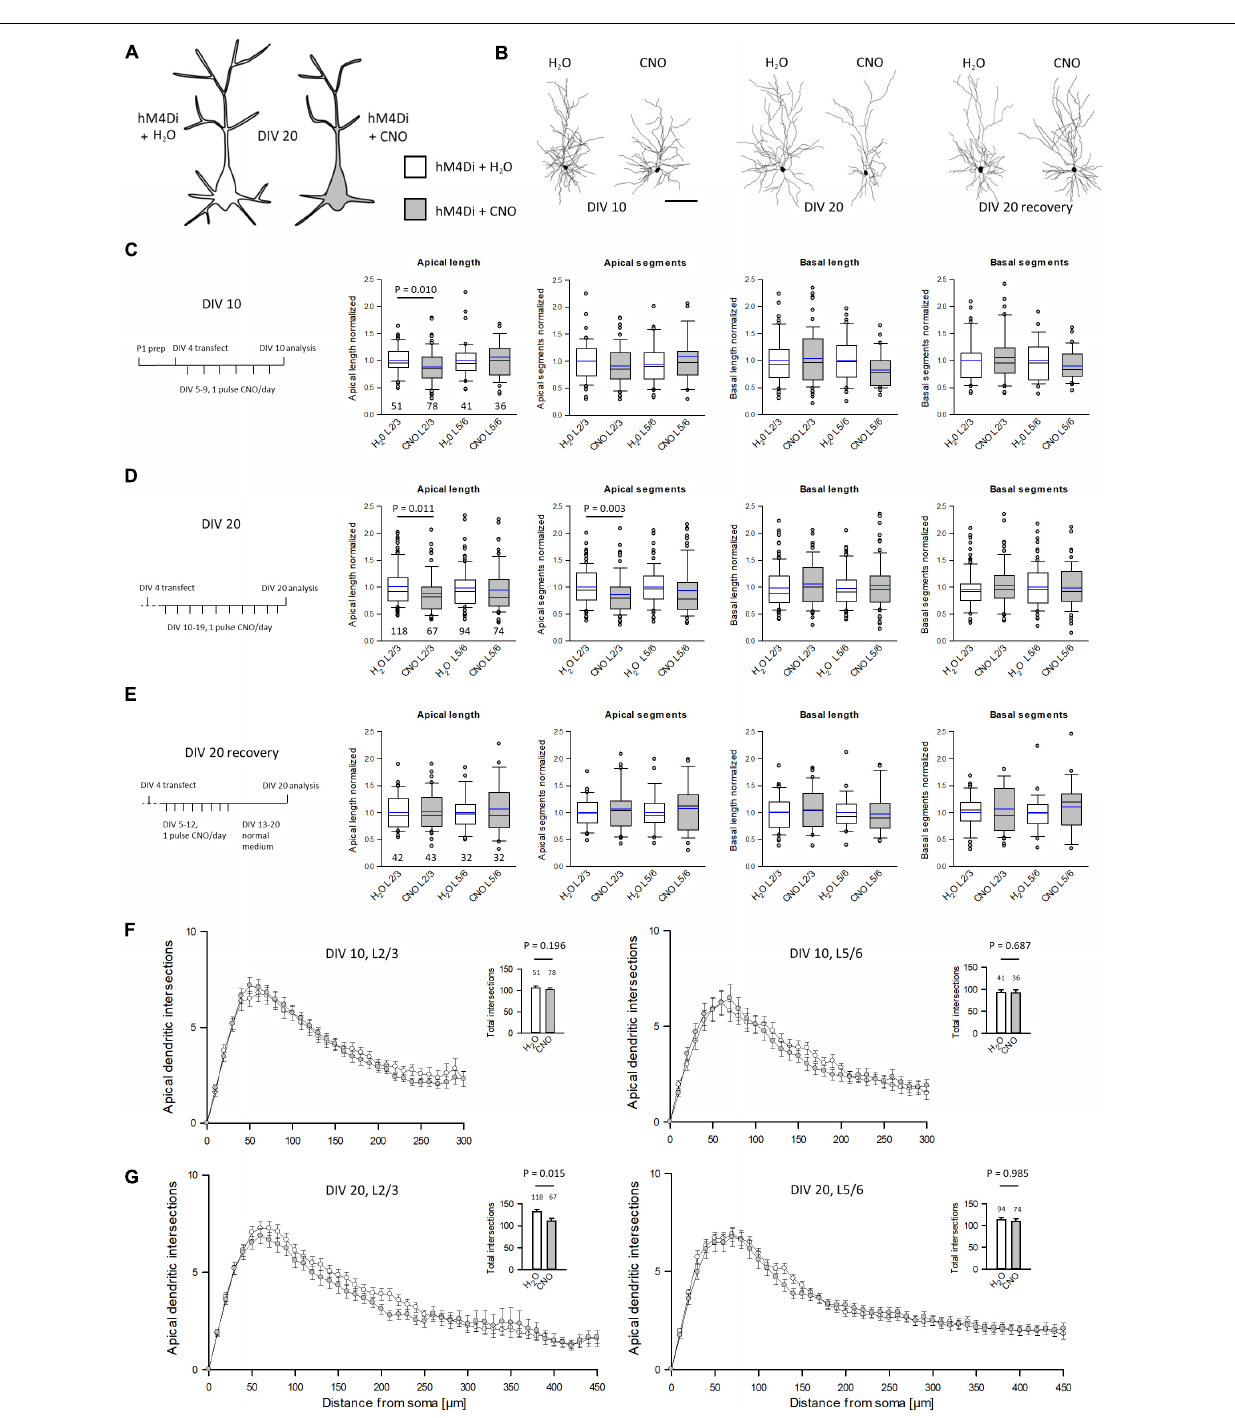
Frontiers in Cellular Neuroscience |